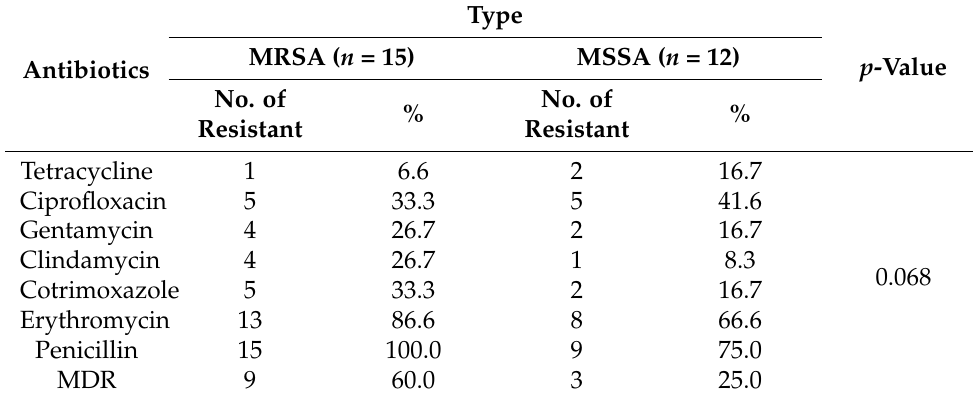
Table 3. Antibiotic resistant pattern between MSSA and MRSA and MDR status.